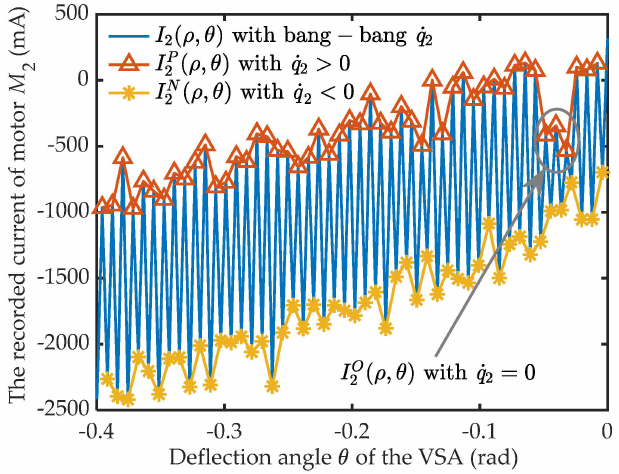
Figure 14. Current stratification of motor M 2 ( AB > OA , ρ = 0.048